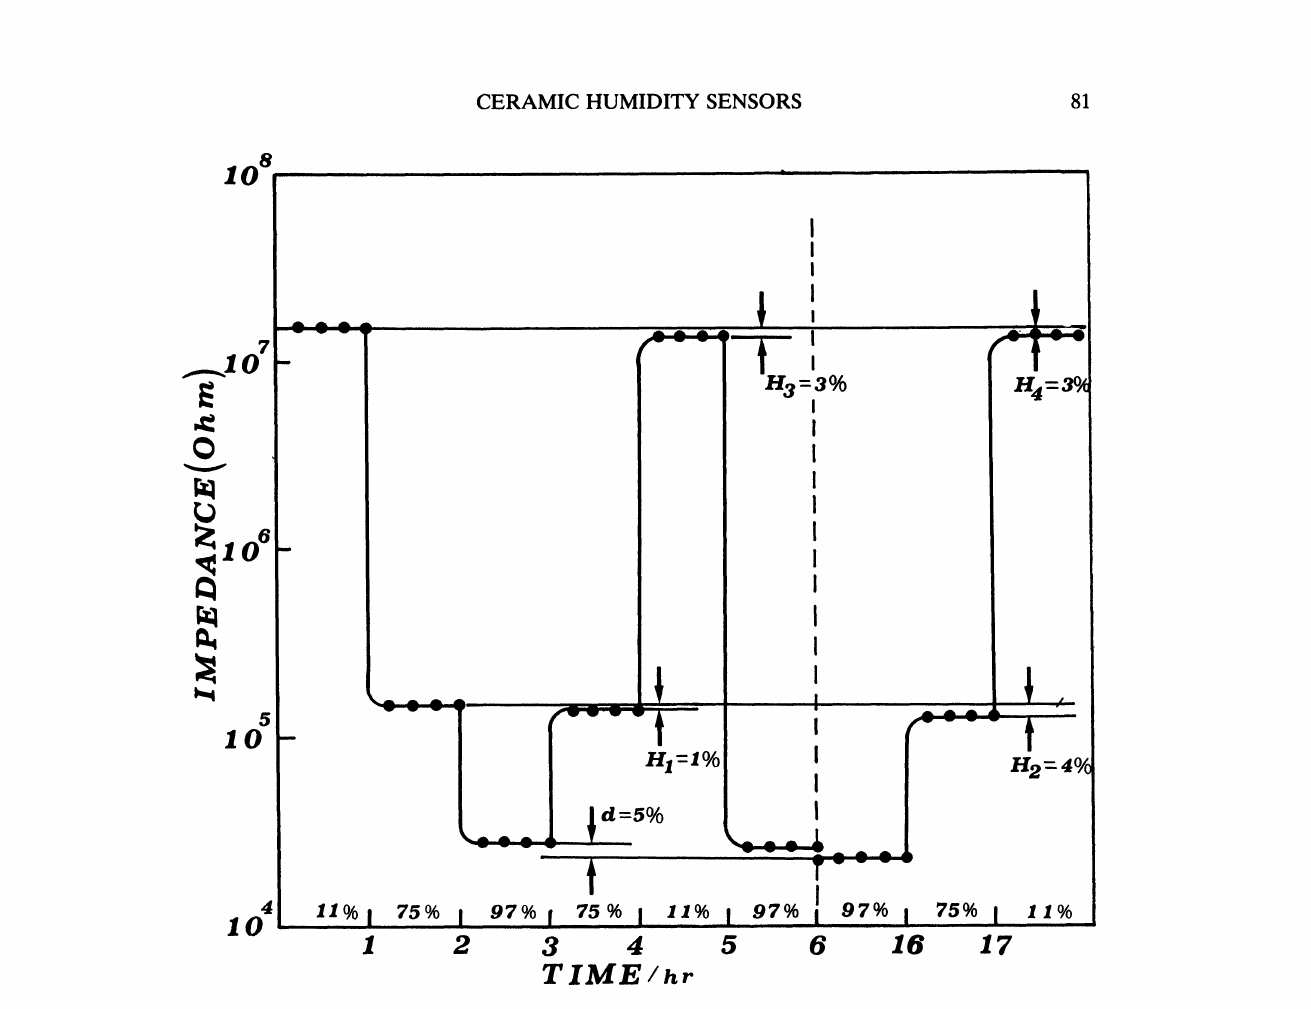
FIGURE 7 The response of 950 C above saturated salt